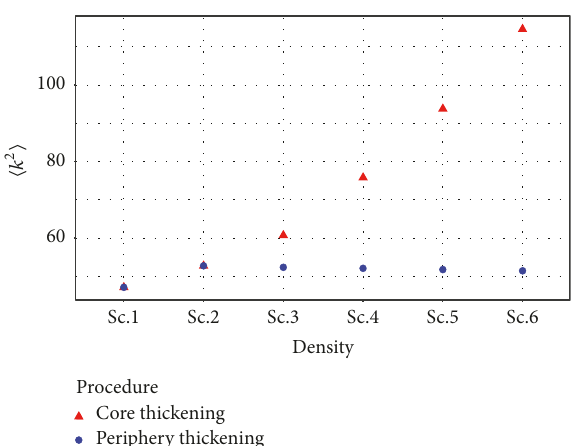
Figure 2: Variance of the degree ⟨𝑘⟩ 2 after the procedure of core and periphery thickening. All results are averaged on 10